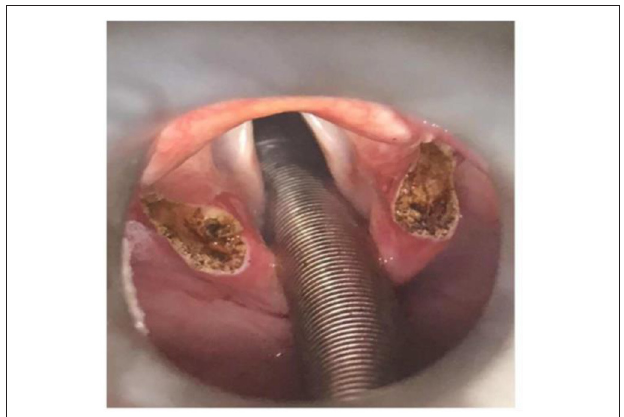
FIGURE 4 | Supraglottoplasty, full procedure, illustrating removal of the cuneiform tubercles on both